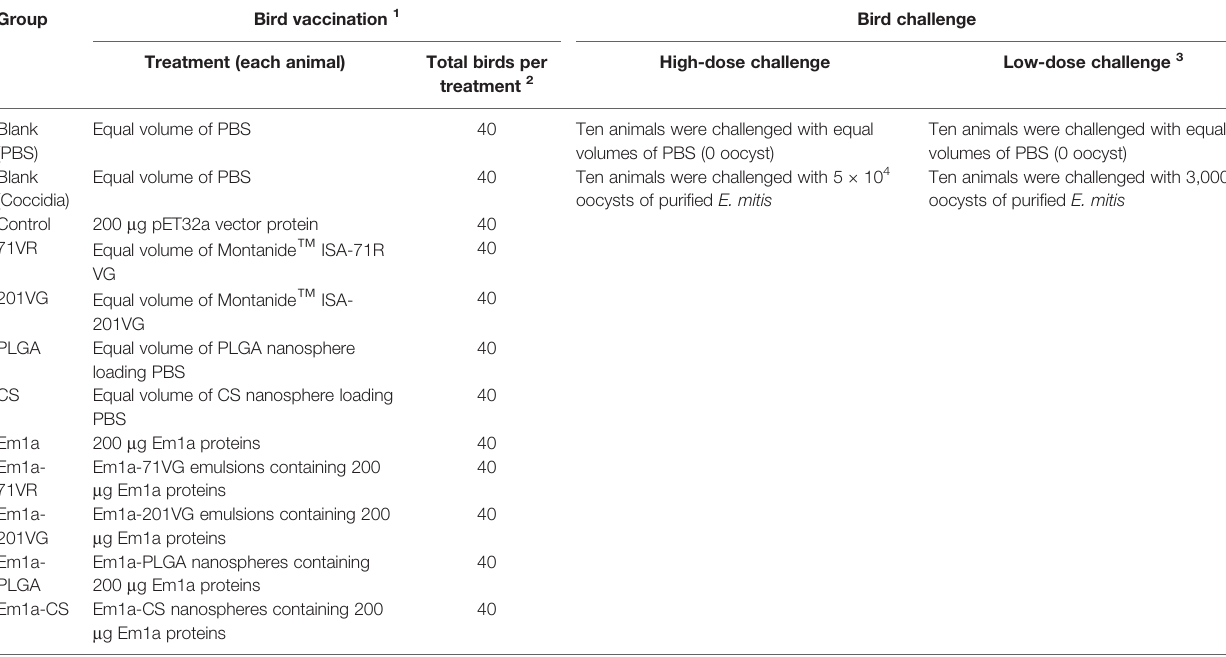
TABLE 1 | Group and immune procedure in animal